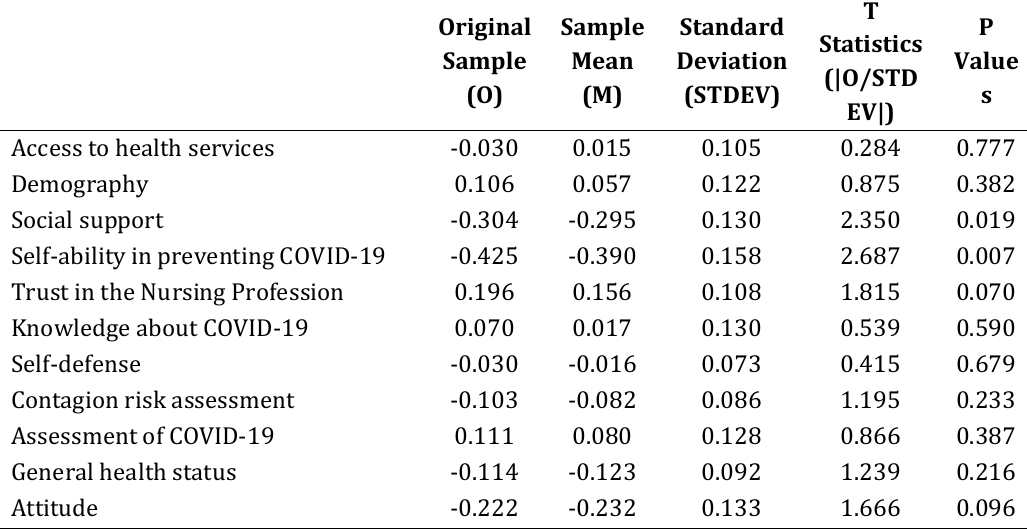
Factors that influence COVID-19 prevention behaviour in the chronic diseases